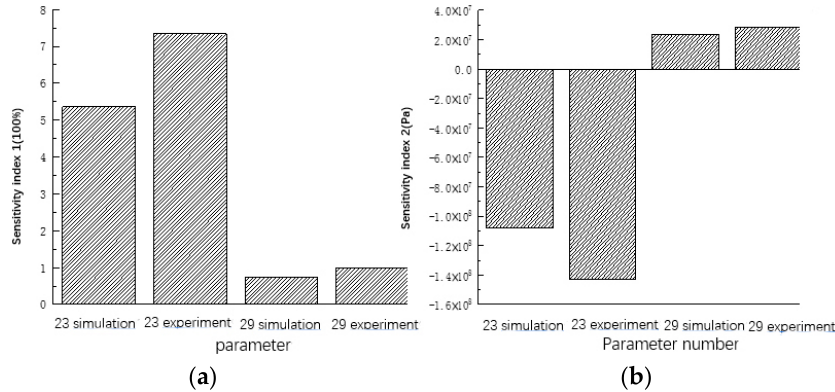
Figure 22. The sensitivity index comparison between simulation and experimental results. ( a ) Sen ‐ sitivity index 1. ( b ) Sensitivity index 2. Table 5. The sensitivity index comparison.